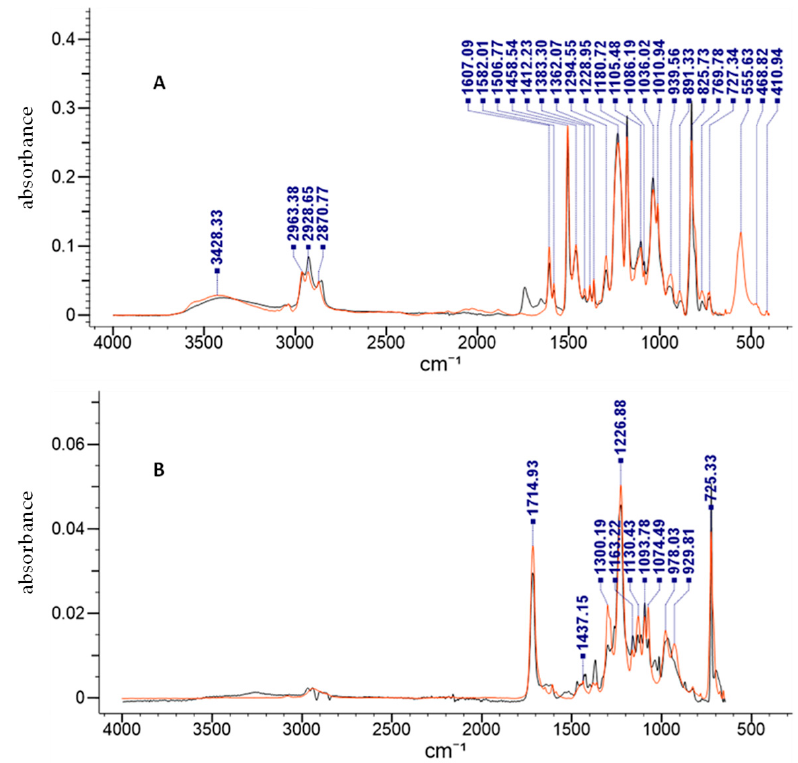
Figure 1. IR spectrum of sample S34 ( A ) and sample S26 ( B ), together with the spectral libraries (red lines). Absorbance vs. wavenumber (cm − 1